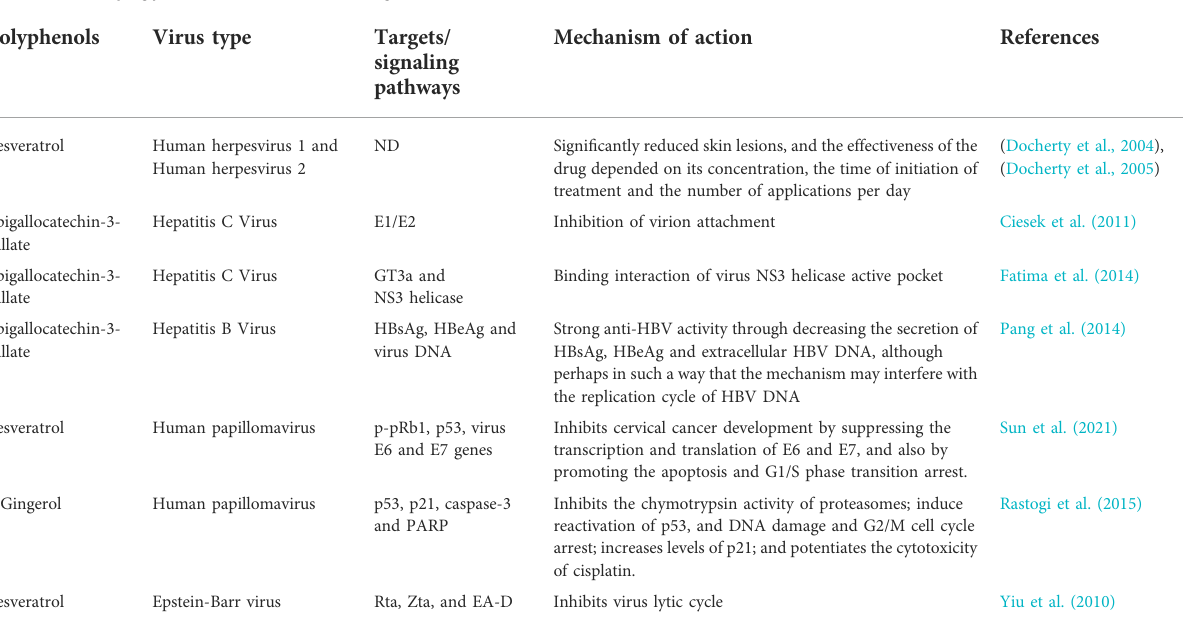
TABLE 8 List of polyphenols with antiviral